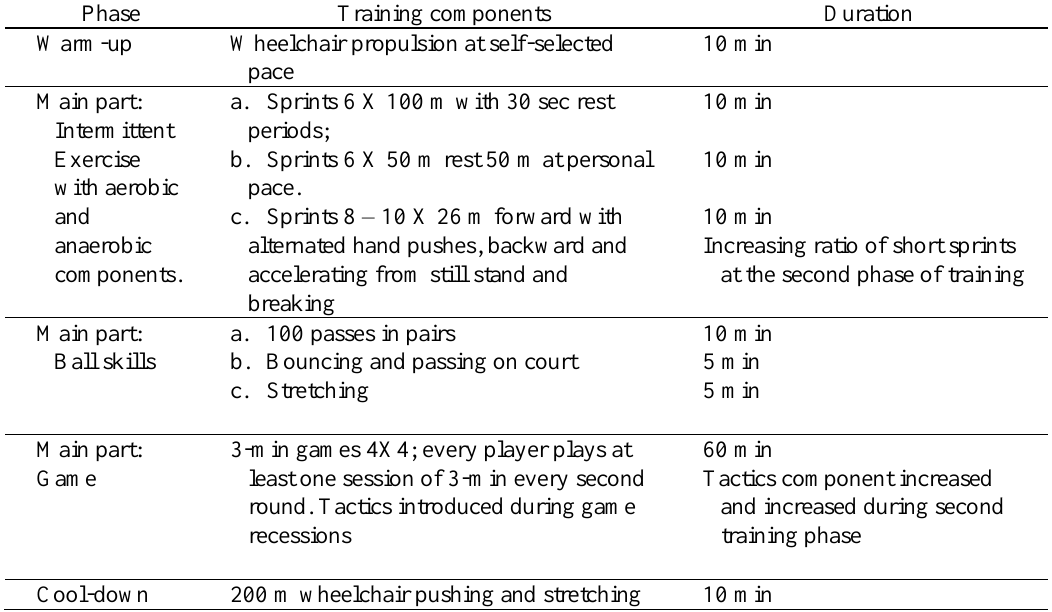
Table 2. Example for a training